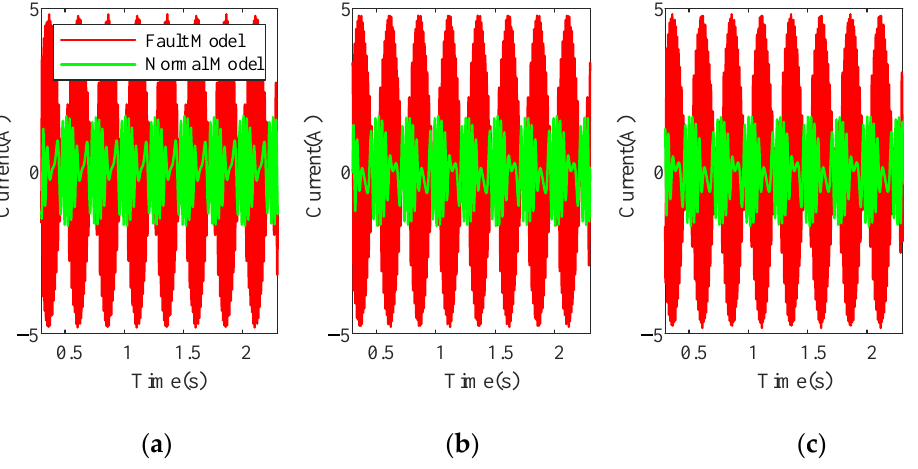
Figure 13. Fault data of displacement sensor open circuit. ( a ) A-phase current; ( b ) B-phase current. ( c ) C-phase current.